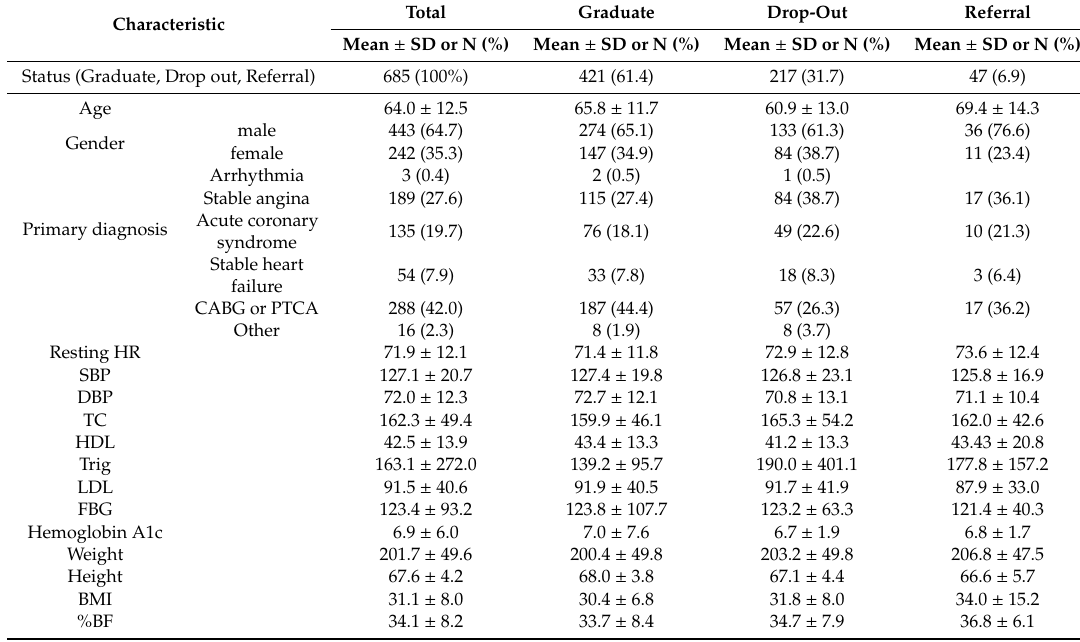
Table 1. Baseline patient characteristics across cardiac rehabilitation status